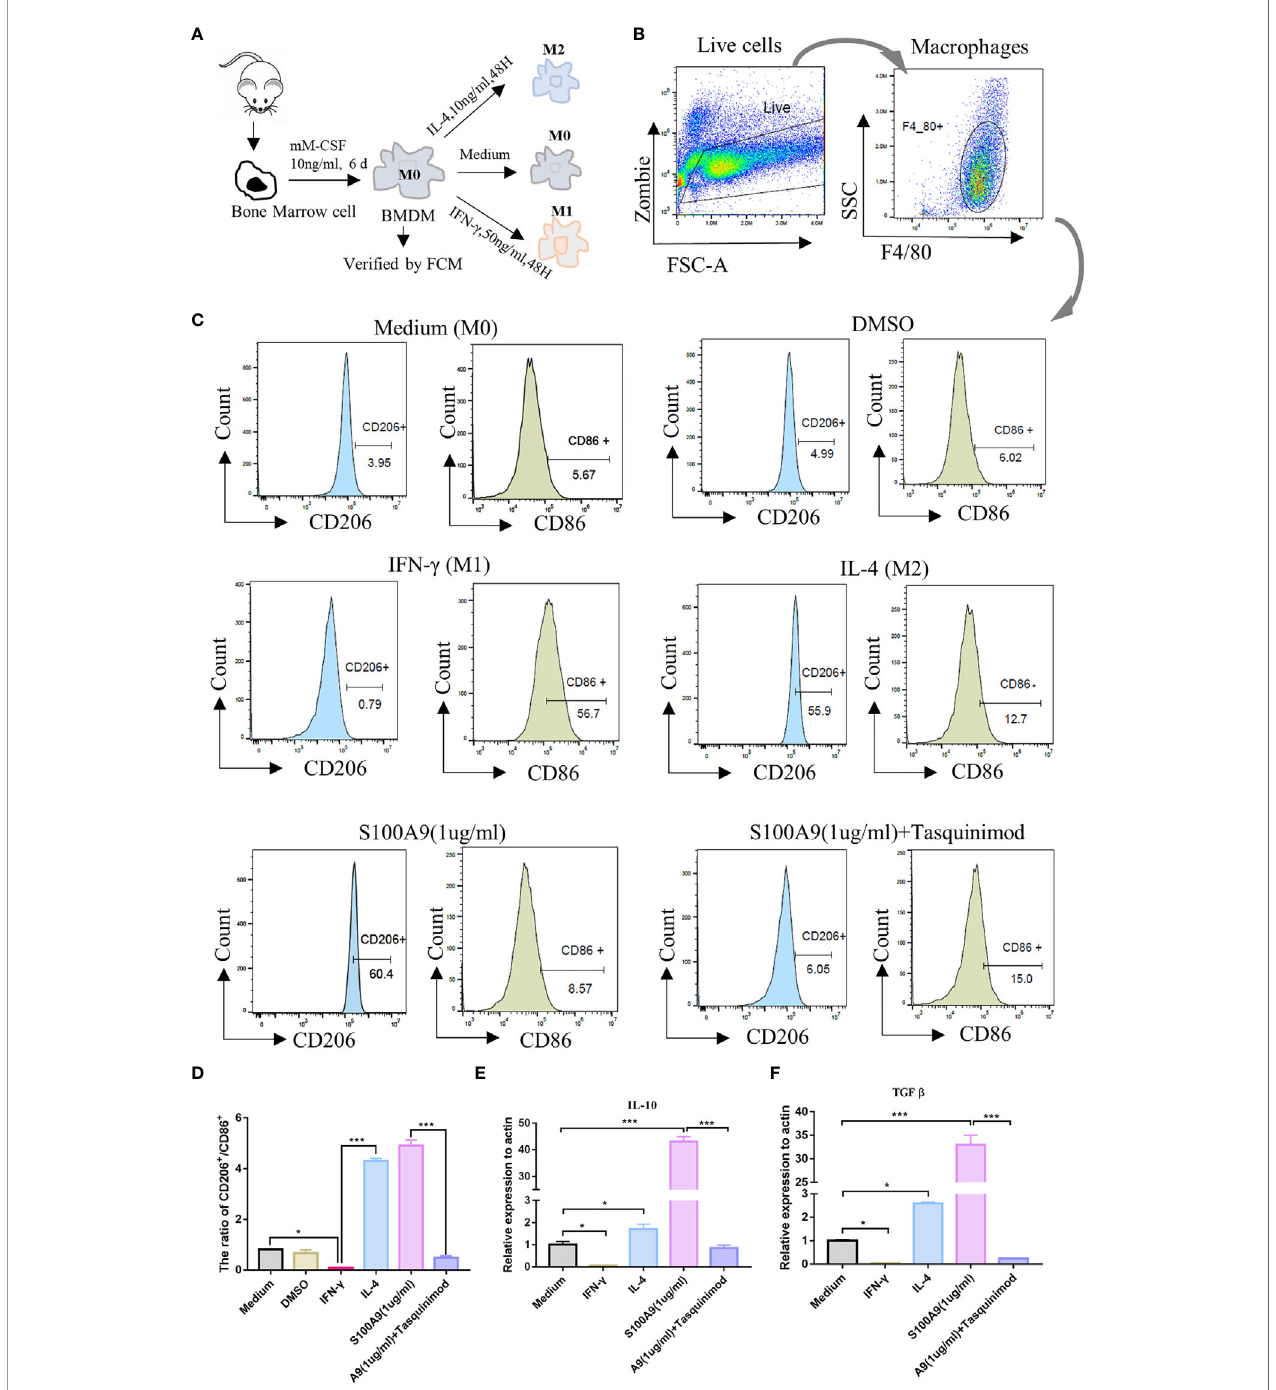
FIGURE 3 | S100A9 treatment promotes the polarization of bone marrow-derived macrophages to M2 in vitro . (A) Mouse (6week, n =4/group) bone marrow single cell suspension was collected through a 70 m m fi lter, and removed red blood cells by red cell lysis solution. BMDMs (M0) were induced with mM-CSF (10 ng/ml, 6 days) in RPMI1640 medium. Further polarization was achieved by adding 50 ng/ml IFN- g (M1), 10 ng/ml IL-4 (M2), DMSO (0.3%), S100A9 (1 µg/ml) and S100A9 (1 µg/ml)+tasquinimod (10 µmol/ml) for 48 more hours. (B, C) Immunotyping was performed by fl ow cytometric analysis to detect live cells, macrophage surface markers (F4/80 + ), M1-M F marker (CD86 + ), and M2-M F marker (CD206 + ). (D) The ratio of CD206 + and CD86 + in different groups. (E, F) Relative mRNA expression of IL10 and TGF b in different groups. Data represent the mean ± standard error( n =3 – 5). *P < 0.05, ***P < 0.001. comparisons between groups using one-way ANOVA followed by Dunnett ’ s multiple comparisons